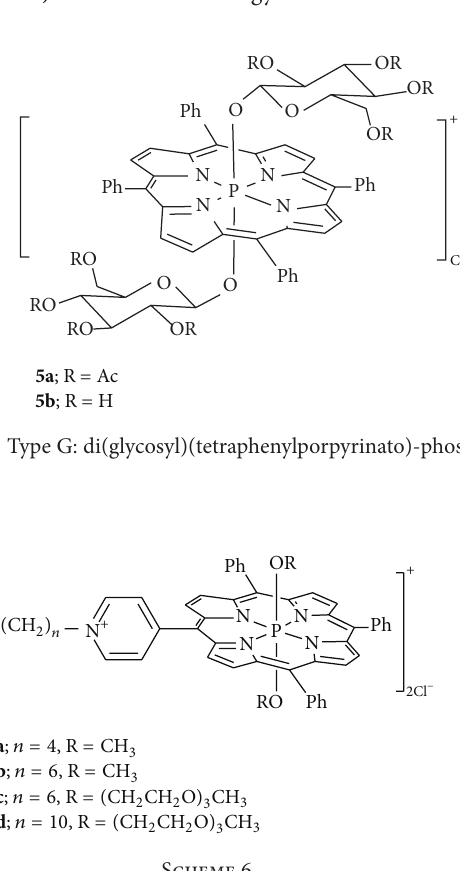
emitted from the inside rather than the walls of cells. The values are summarized in Table observed [ P ] ad